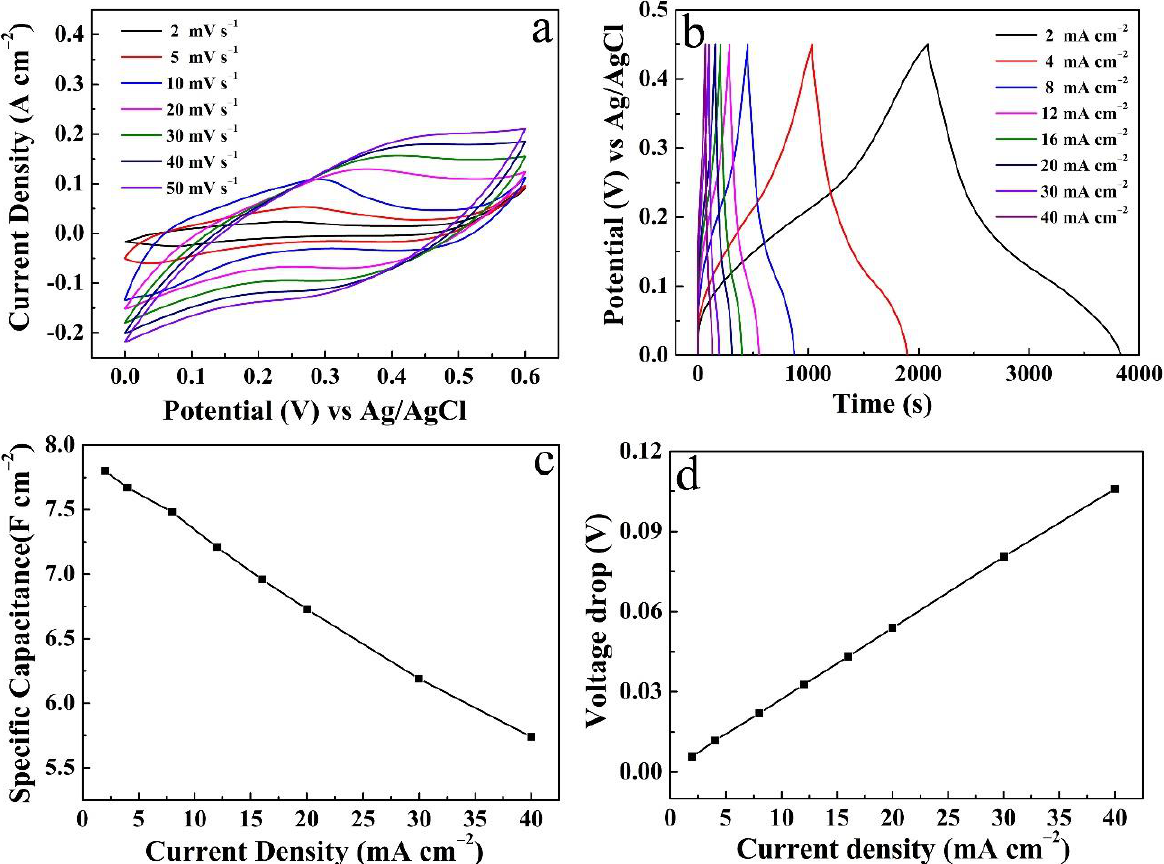
Figure 7. Electrochemical properties of Cu(OH) 2 /NCS electrode (S-4): ( a ) CV curves; ( b ) GCD curves at different current densities and corresponding C s ( c ) and the voltage drops ( d